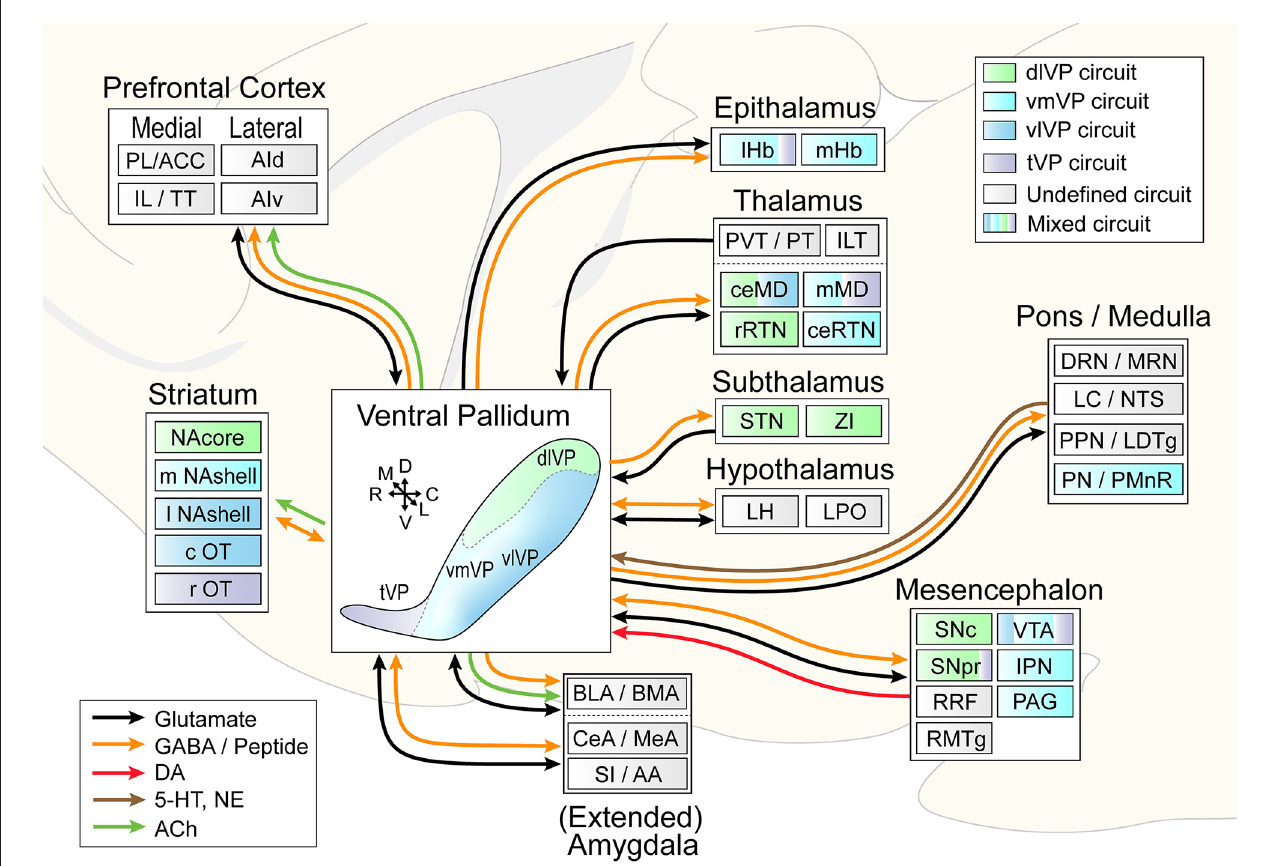
FIGURE4 Circuit diagram illustrating VP subcircuit connectivity. In the center, the distinct VP subregions are shown by different colors that are preserved throughout the diagram to indicate known preferential subcircuit connectivity patterns. The ventromedial (light blue) and ventrolateral (dark blue) VP are shown as a color gradient in this representation from medial (back) to lateral (front), but these regions do occupy the entire mid- to caudal extent of the ventral VP. Connected areas are grouped by anatomical region. Arrows indicate VP efferents and afferents, and different colors represent different neurotransmitters. Multicolored regions receive inputs from two or three different VP subregions, and gray regions have not been investigated for subcircuit connectivity. ACC, anterior cingulate cortex; PL, prelimibic cortex; IL, infralimbic cortex; TT, tenia tectum; AId/AIv, dorsal and ventral anterior insular cortex; lHb/mHb, lateral and medial habenula; PVT/PT, paraventricular and paratenial nucleus of the thalamus; ILT, intralaminar nuclei of the thalamus; ceMD/mMD, central and medial dorsomedial nuclei of the thalamus; rRTN/ceRTN, rostral and central parts of the reticular thalamic nucleus; STN, subthalamic nucleus; ZI, zona incerta; BLA/BMA, basolateral and basomedial nucleus of the amygdala; CeA/MeA, central and medial nucleus of the amygdala; SI/AA, substantia innomunate and anterior amygdaloid area; DRN/MRN, dorsal and median raphe nuclei; LC/NTS, locus coeruleus and nucleus of the solitary